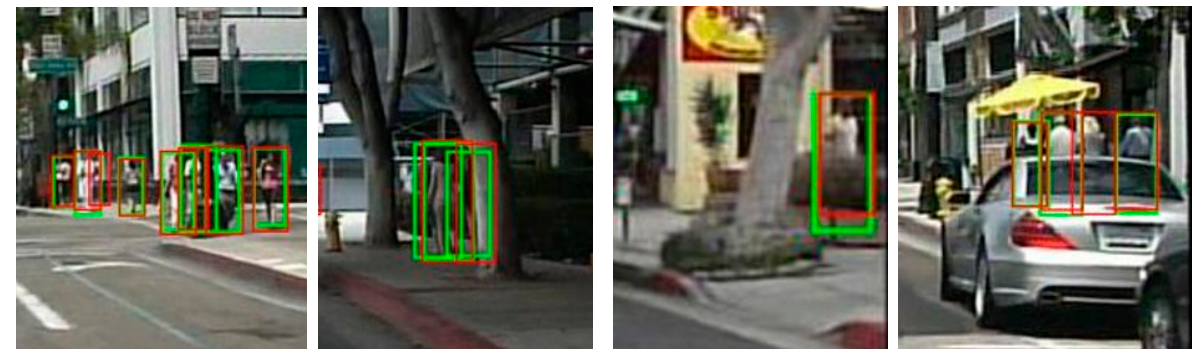
Figure 1. Examples of occluded pedestrians in traffic scenes. The green bounding boxes are the ground truth, the red bounding boxes denote the detections of our method .